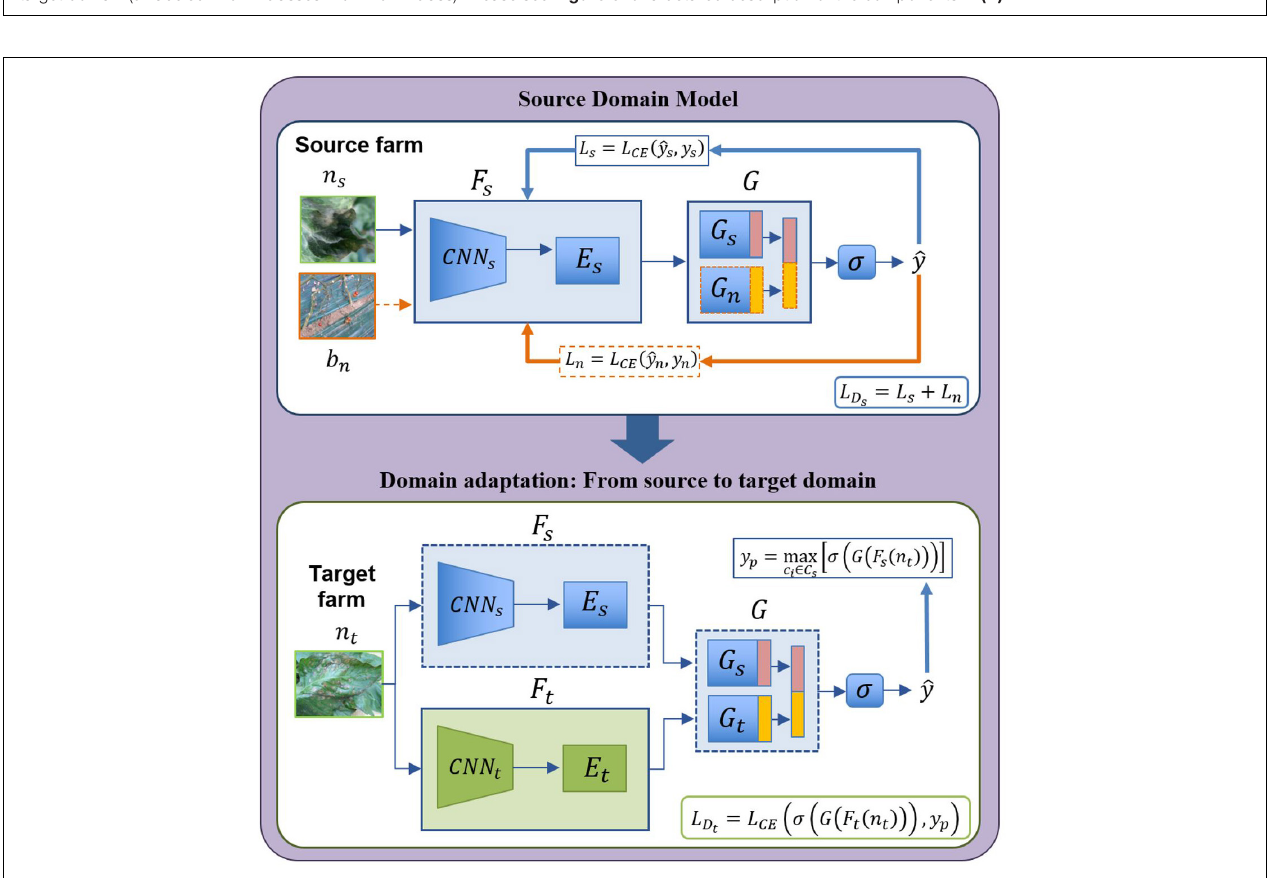
FIGURE 5 | Open set domain adaptation module. “Source farm” represents the data (labeled) of the environments used for training the source domain model. Data (unlabeled) for the target domain comes from a different “Target farm” to test the model on unseen samples which belong to either one of the known classes or unknown